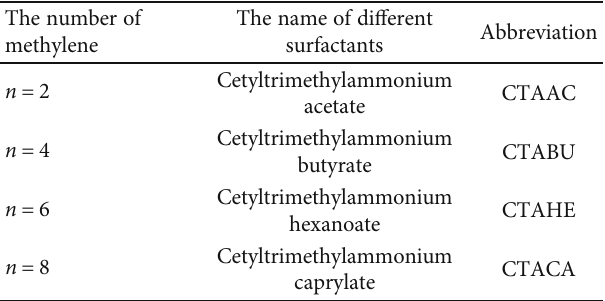
Table 2: The abbreviation of the dicarboxylic cationic surfactants.